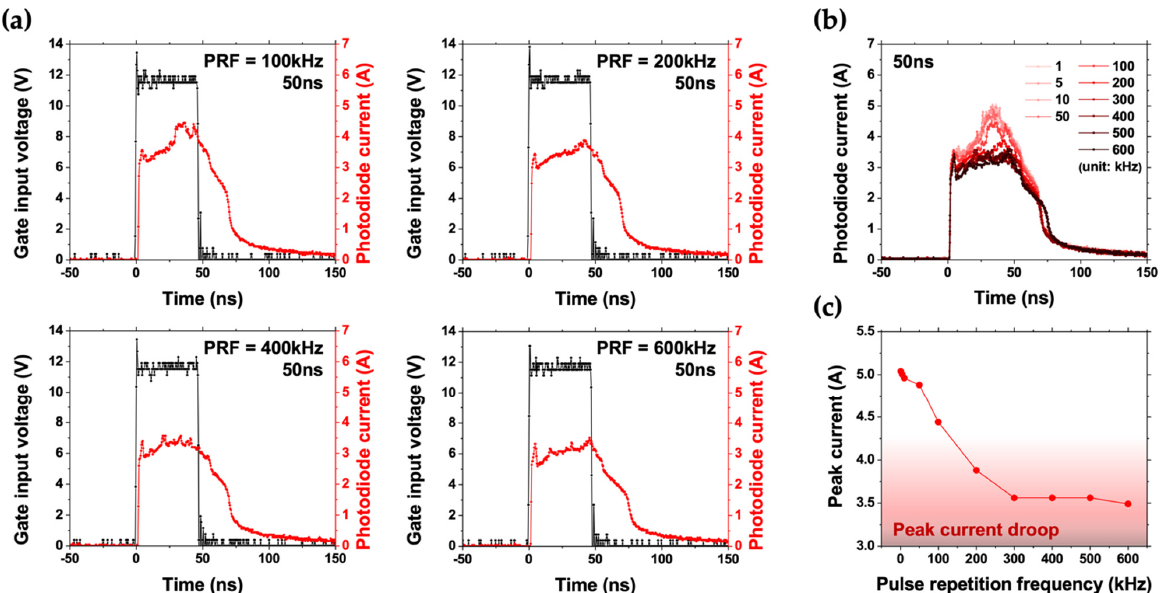
Figure 2. Characteristics of the integrated system and the corresponding photodiode responses from the employed PCSEL with fixed pulse width of 50 ns. ( a ) Photodiode responses from the PCSEL with distinct pulse repetition frequencies. The PCSEL is activated by gate input pulses of the integrated system. The black lines are the gate input voltages (V) from a function generator (left y -axis) while the red lines are the corresponding photodiode currents (A) caused by the irradiation of PCSEL (right y -axis). ( b ) A sequence of photodiode responses from the PCSEL with various pulse repetition frequencies for comparison. The higher the pulse repetition frequency, the lower the photodiode peak current. ( c ) Corresponding peak currents extracted from ( b ). Due to the severe self-heating effect, PCSEL operated at a high pulse repetition frequency will suffer from an output droop. Afterward, the corresponding peak current drops from 5.04 A to 3.49 A at 1 kHz and 600 kHz,